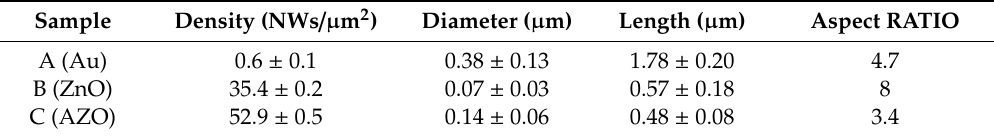
Table 2. Characteristics of ZnO NWs grown on different seed layers.